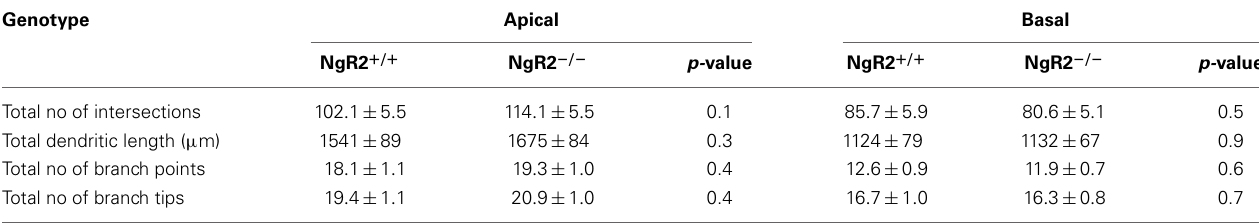
Table 1 | Morphological analysis of apical and basal dendrites in CA1 hippocampal cells from NgR2 + / + and NgR2 − / − animals. Genotype